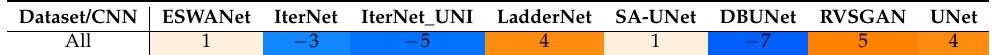
Table 5. CNN model ranking based on the Copeland score for all pairwise comparisons. The larger the value is, the more significant the model is clinically. Absolute values of the Copeland score are in the [ − 8,8 ] range.